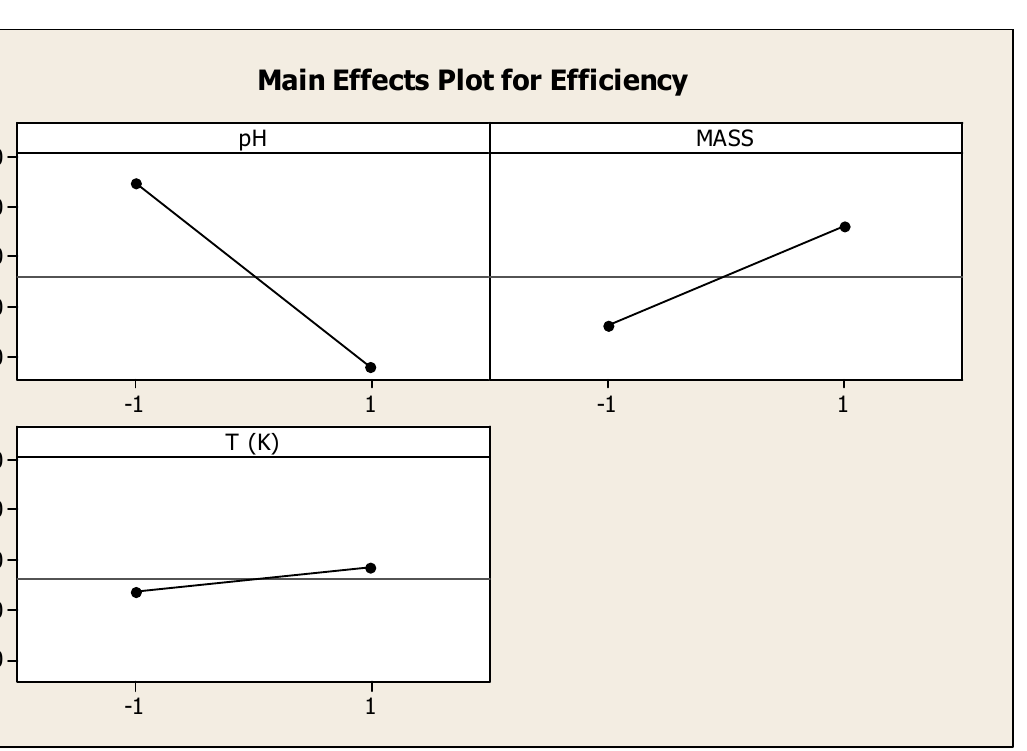
Figure 10. Effects of mutual interactions among factors on BR dye removal efficiency.